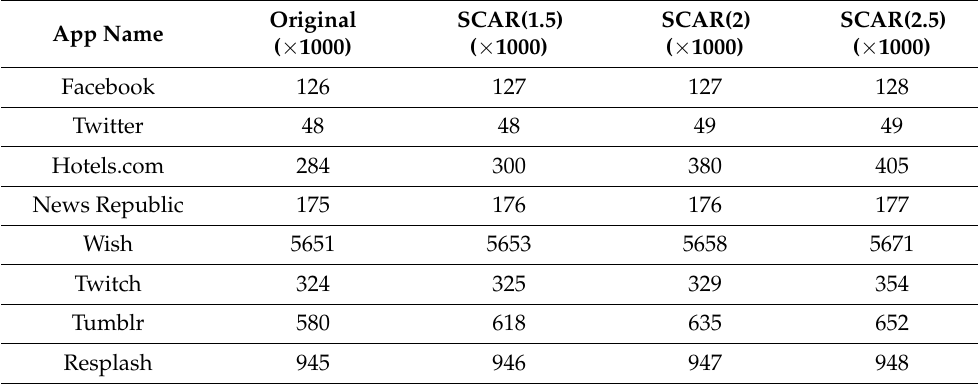
Table 3. Network traffic (bytes) per minute during scrolling.